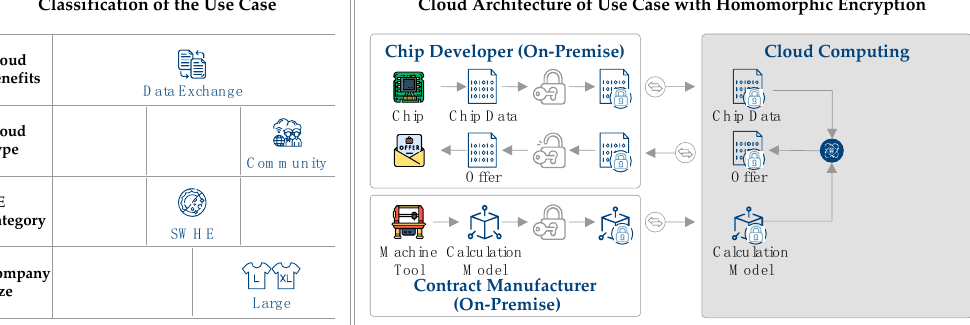
Figure 8. Classification and cloud architecture for contract manufacturing of chipsets.